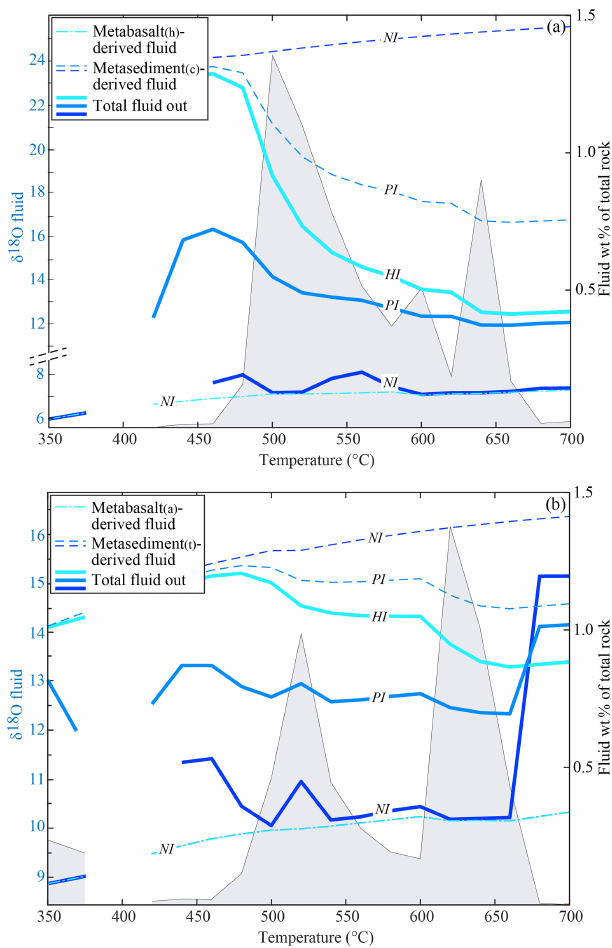
Figure 6. Double plot diagrams showing the oxygen isotope com- position of the released fluids (left axis, coloured lines) and the amount (in wt% of the total rock) of the total fluid released by the systems (right axis, grey field) for each interaction case in the ab- sence of serpentinite-derived fluid input. (a) Modelled fluid δ 18 O values and amount for the system metabasalt ( h ) + metasediment ( c ) . (b) Modelled fluid δ 18 O values and amount for the system metabasalt ( a ) + metasediment ( t ) . Dashed lines show the δ 18 O val- ues of the fluids released by each rock type and solid lines the δ 18 O values of the final fluids released by each system. In the case of HI, all the metabasalt-derived fluid infiltrates the metasedi- ment. Hence the final fluid released overlaps with the fluid expelled by the metasediment and only one line is represented (light blue, marked as HI). Because the δ 18 O values of the fluids released by the metabasalts are not affected by the degree of interaction, all three cases are represented by one line (marked as